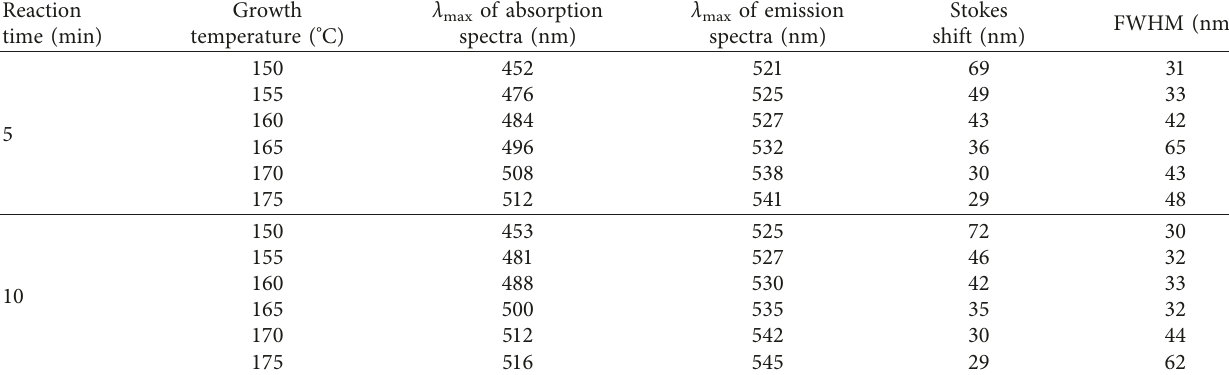
Figure 5: Absorbance and emission spectra of CdSe/ZnS core/shell QDs synthesized at 160 ° C (a) and 170 ° C (b) for different reaction times, plotted as a function of photon Table 1: Maximum wavelengths of UV-Vis absorption and PL emission spectra and the corresponding Stokes shift and the full width at half maximum (FWHM) of bare CdSe core QDs at different temperatures for 5 and 10 minutes of reaction times.